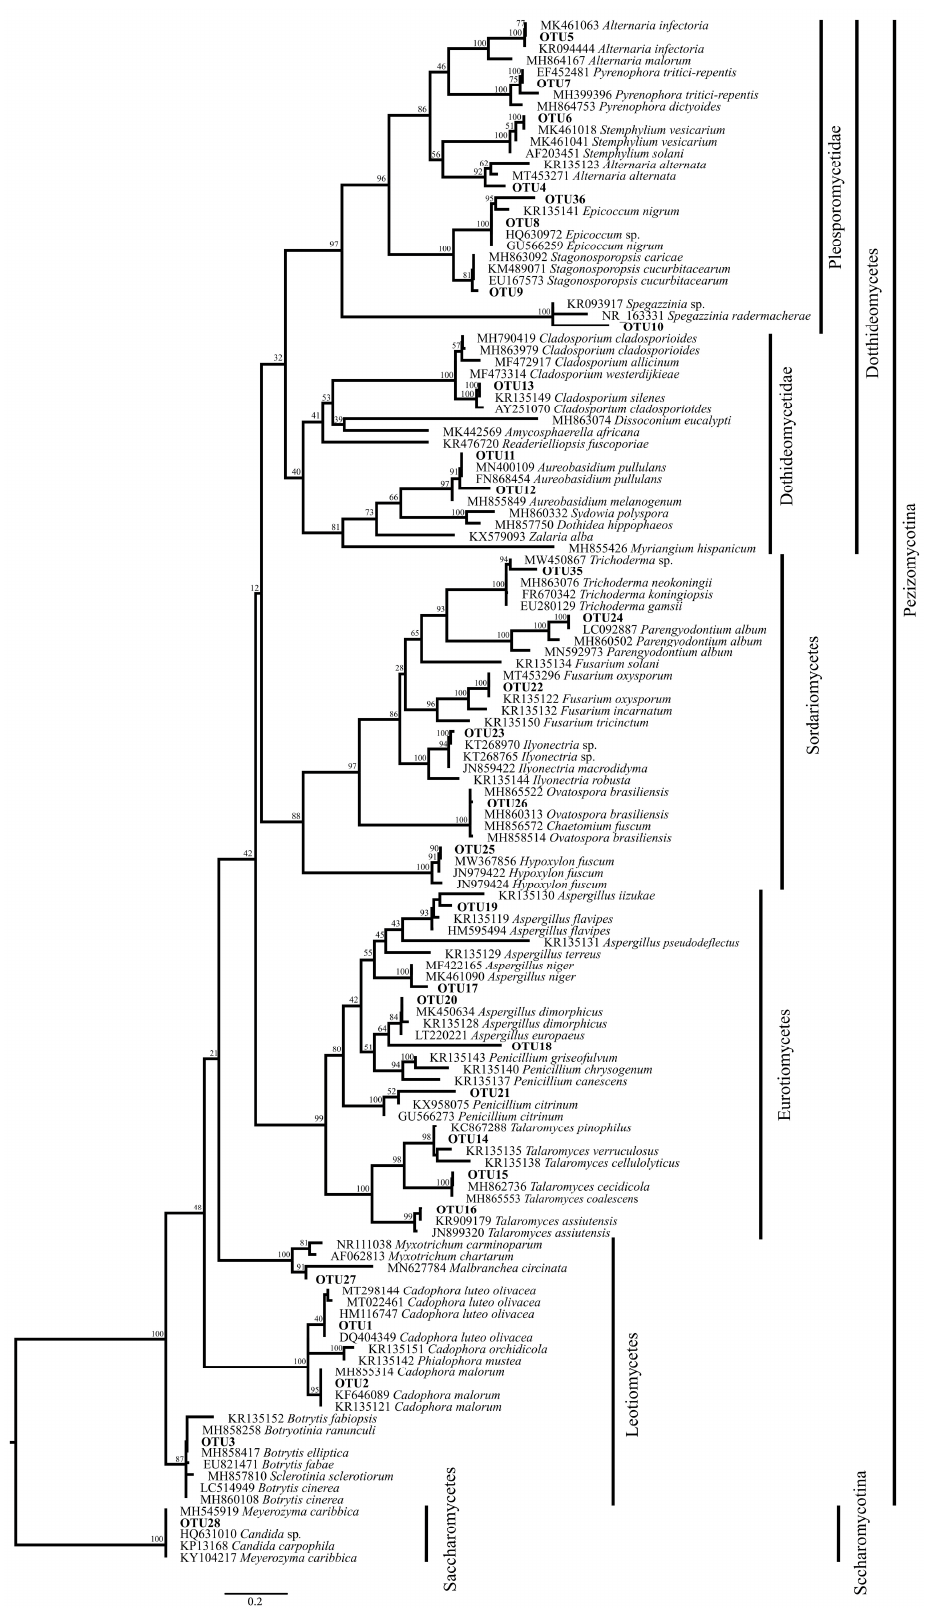
Figure 1. Phylogenetic tree of the Ascomycetes OTUs identified in this study (in bold). Numbers near the branches indicate bootstrap values (percentage over 1000 replicates).